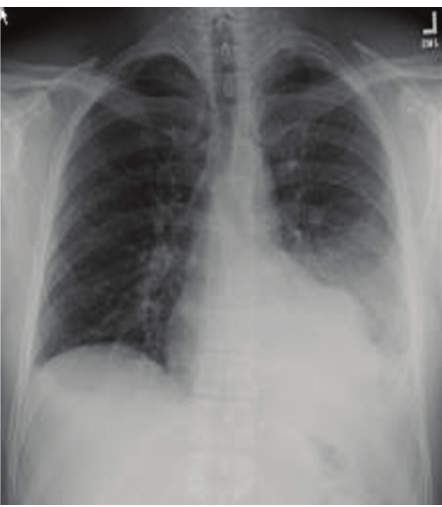
Figure 1: Chest X-ray on day 1 of patient